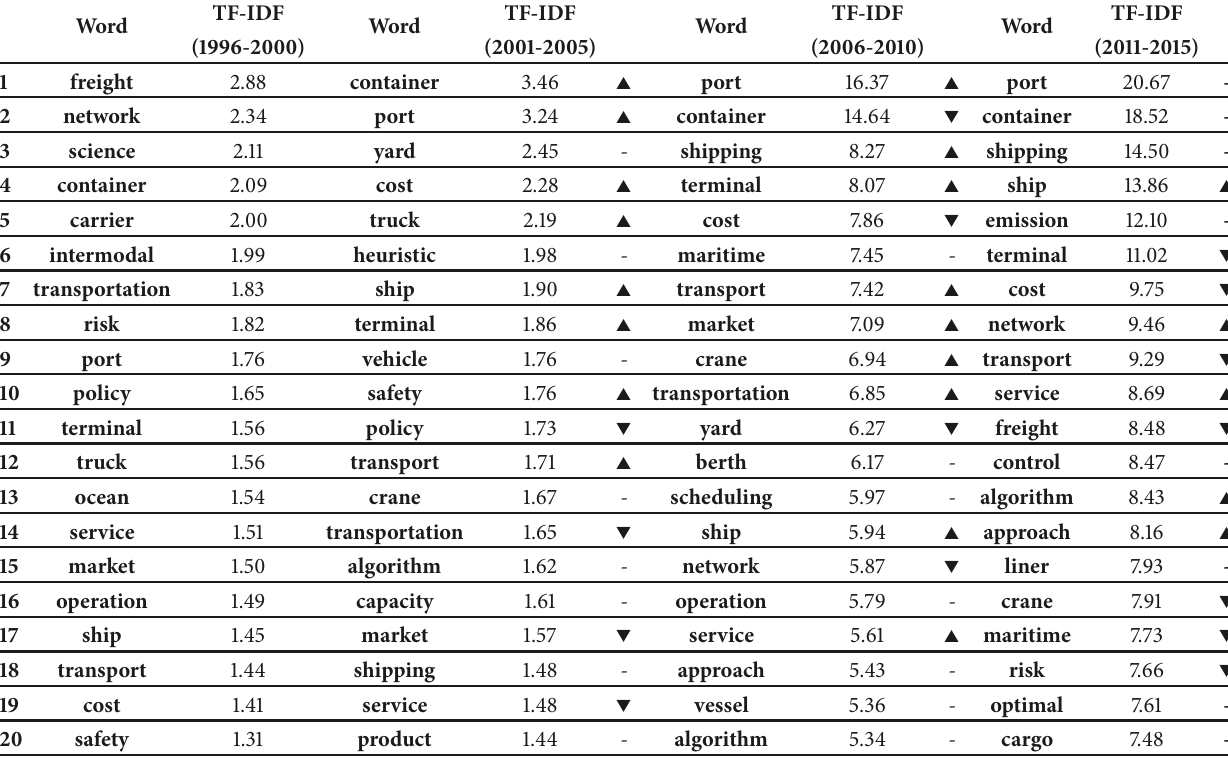
Table 12: Ranking dynamics of research